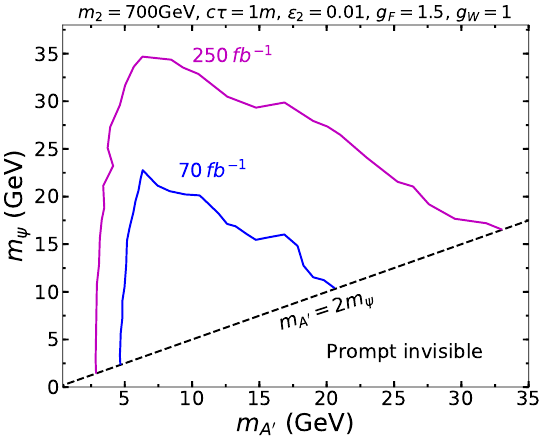
Figure 7 . The contour of the expected signal events at the 13 TeV LHC, as a function of m A 0 and m . We choose m 2 = 700 GeV, c(cid:28) = 1 m, (cid:15) 2 = 0 : 01, g F = 1 : 5 and g W = 1 : 0. The blue and magenta contours indicate the needed integrated luminosity of 70 fb (cid:0) 1 and 250 fb (cid:0) 1 respectively, to generate 10 events.